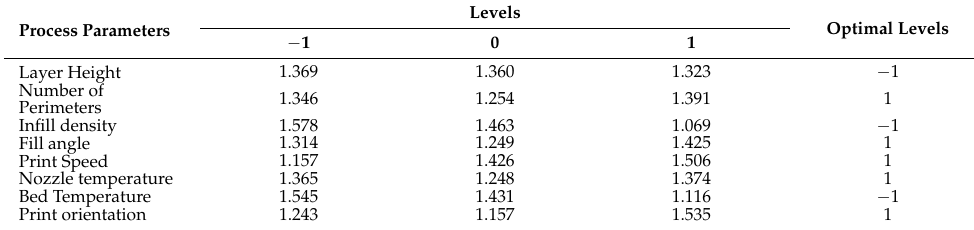
Table 5. Optimal levels for combined responses based on the grey relational grade. Process